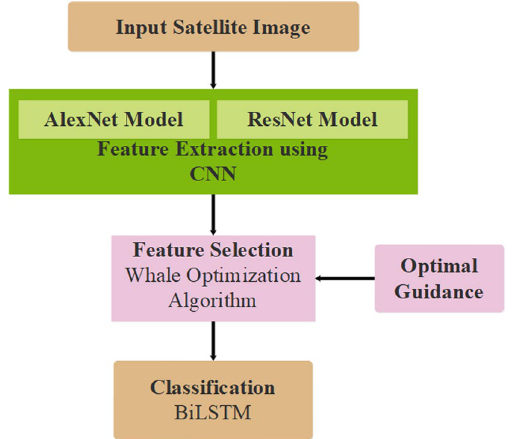
Fig. 1 The overall process in satellite image